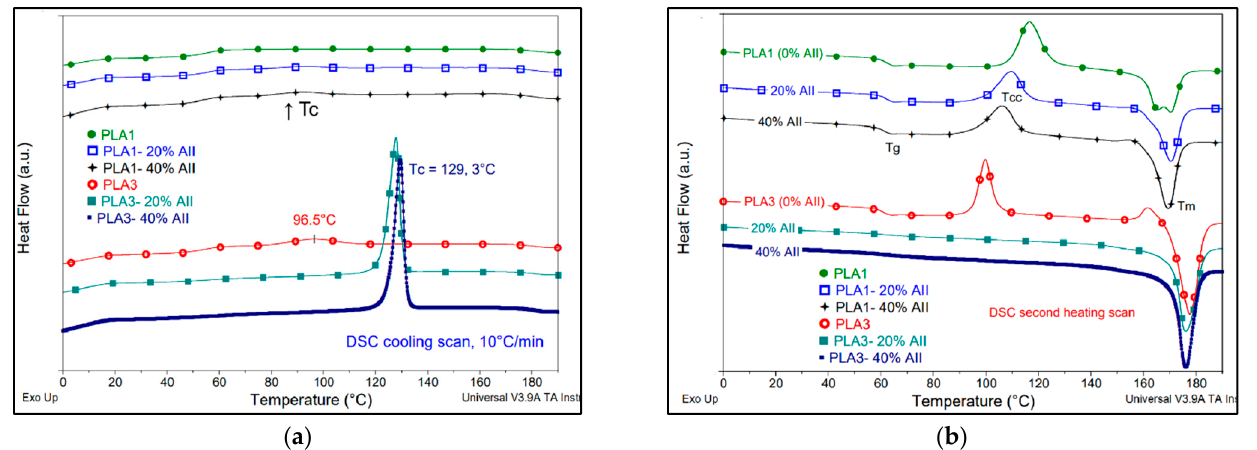
Figure 9. ( a , b ). Comparative DSC curves of neat PLAs (PLA1 and PLA3) and those of PLA1 − AII and PLA3 − AII composites obtained during ( a ) cooling and ( b ) second DSC heating (10 °C/min). Table 3. Comparative DSC results of neat PLAs and PLA–AII composites obtained using different PLA grades as polymer matrix (second DSC heating scan, by 10